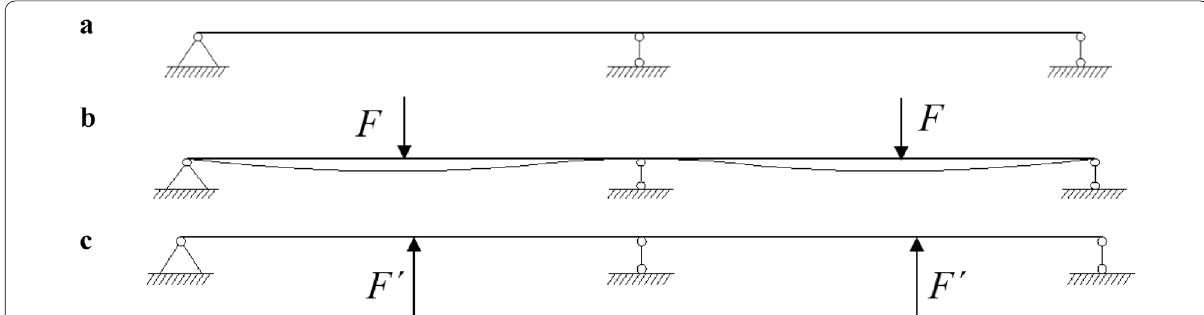
Fig. 5 Prestressed control process. a Before the initial load applied; b after the initial load applied; c control